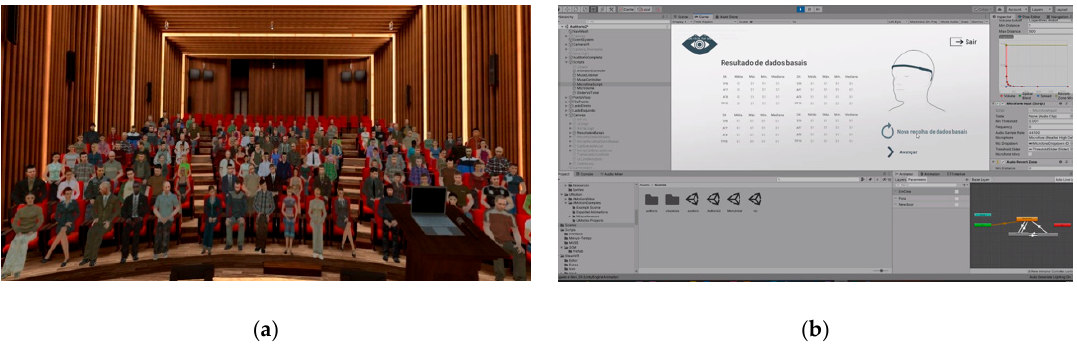
Figure 2. ( a ) Virtual environment simulating an auditorium; ( b ) Control